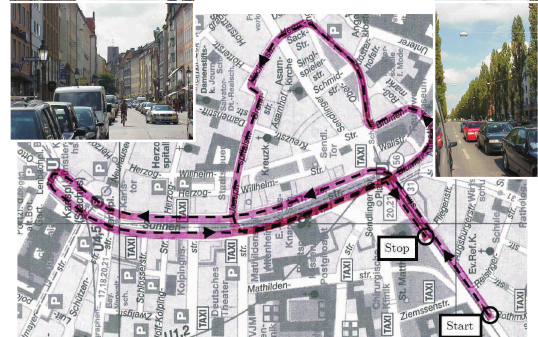
Figure 5: Measurement track for the car channel in the city center of Munich near the Sendlinger